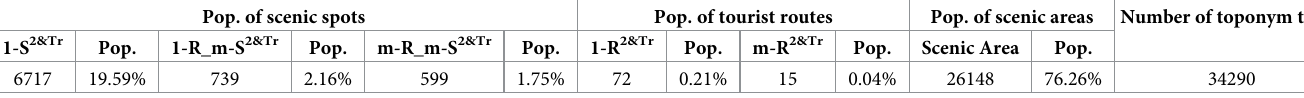
Table 3. Calculated results of TDP (abbreviated pop.) at Jiuzhaigou scenic area scales. Pop. of scenic spots